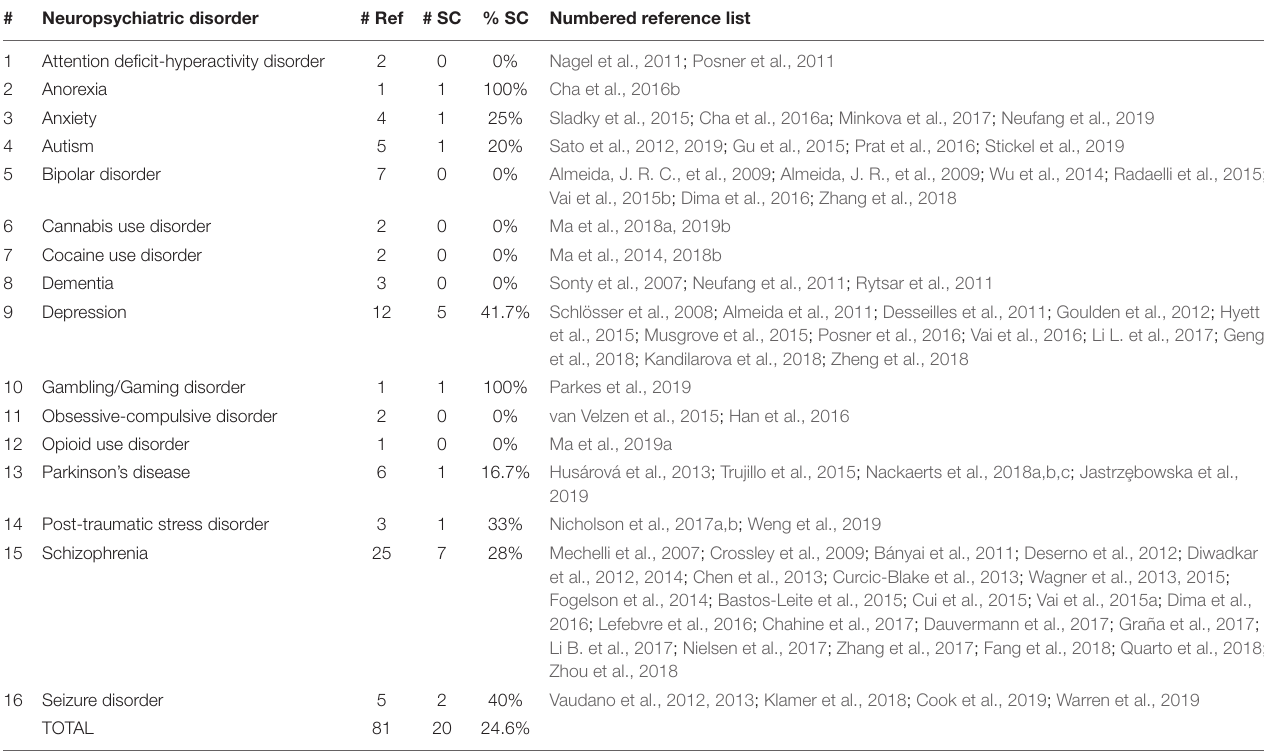
TABLE 1 | Summary of neuropsychiatric disorders represented in the literature review by numerical count and percentage of total number of references. # Neuropsychiatric disorder